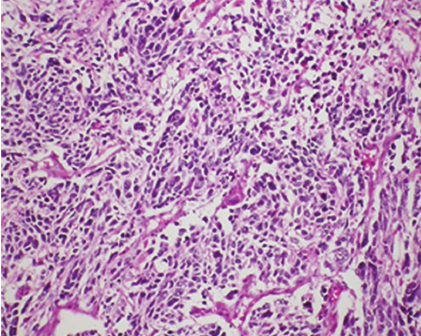
Figure 3: Histological features of the lesion containing epithelial and mesenchymal component consistent with pulmonary blastoma (3: HES × 100).